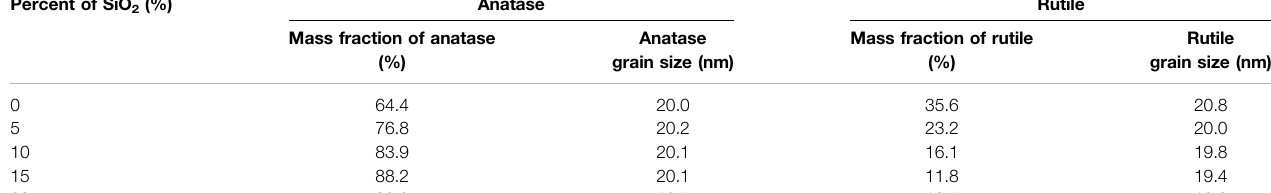
TABLE 2 | The composition of the anatase, rutile phase, and the crystallite size of the TiO 2 /SiO 2 Nc (0 – 50%). Percent of SiO 2 (%) Anatase Rutile Mass fraction of anatase Anatase Mass fraction of rutile (%) grain size (nm) (%)